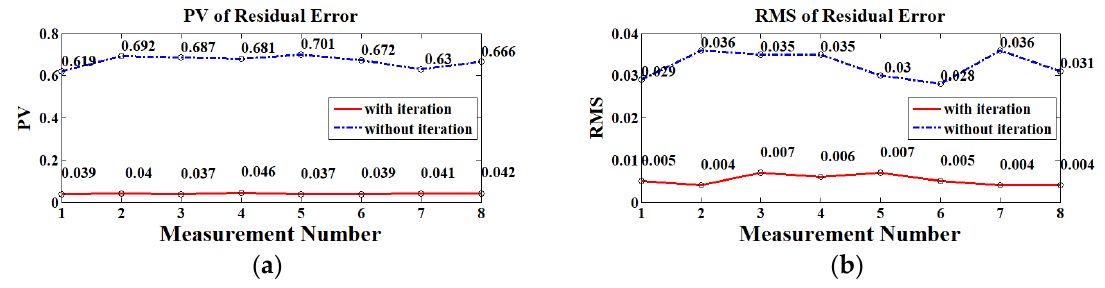
Figure 10. ( a ) Data comparison of eight groups of the peaks-and-valleys (PV) value of residual error; ( b ) the root mean square (RMS) value of the residual error.